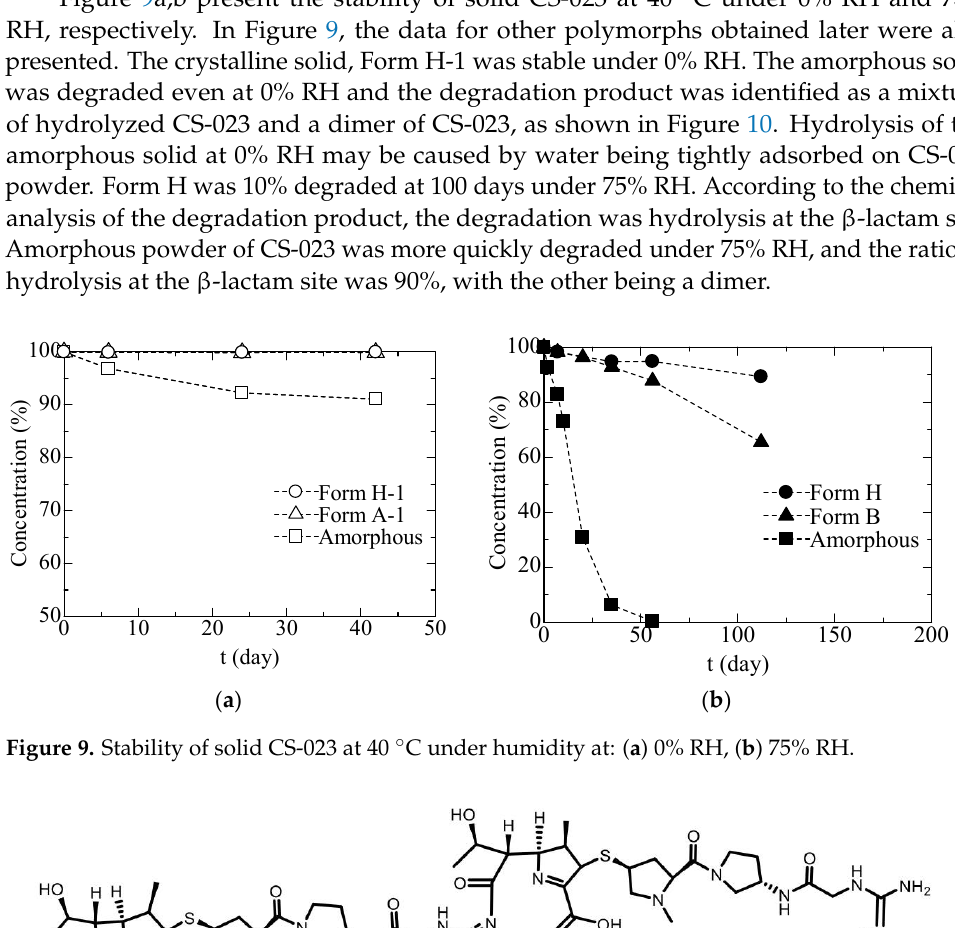
Figure 10. Chemical structure of the degradation product of amorphous CS-023, dimer, recovered after incubation at 0%